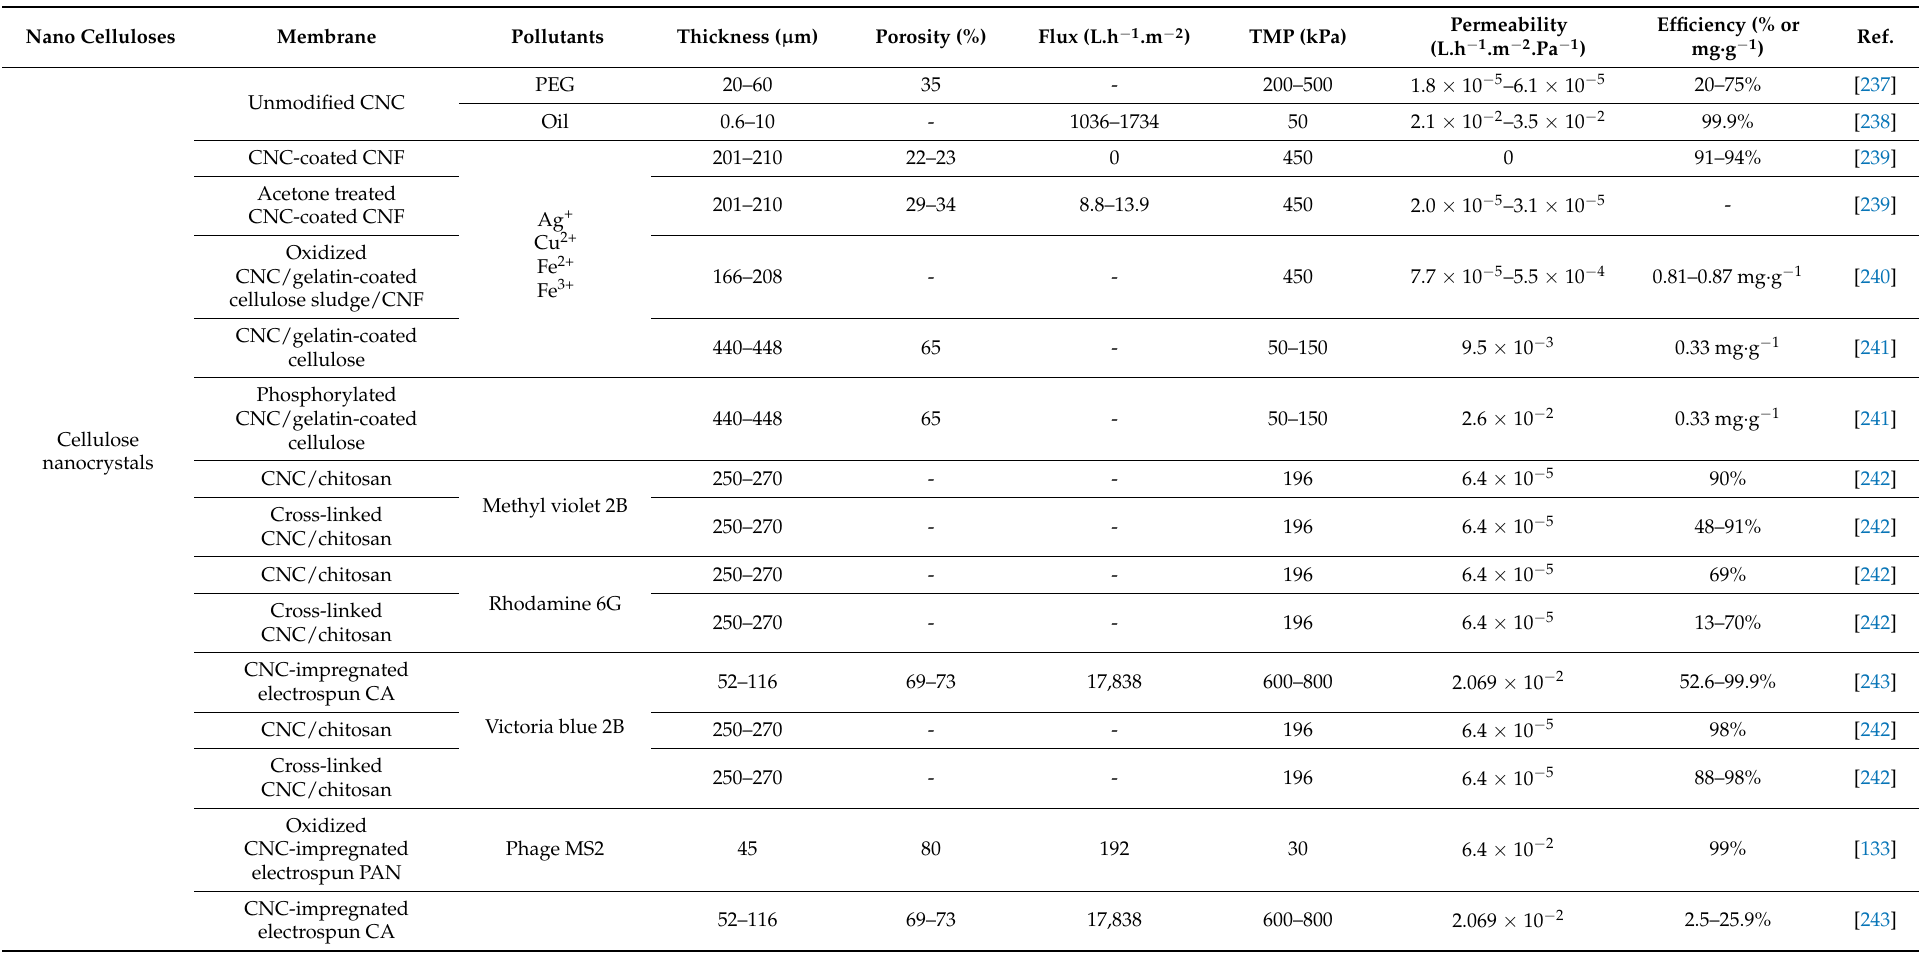
Table 7. Filtration membranes are made of nanocelluloses for wastewater treatment. CA, cellulose acetate; TMP, transmembrane pressure; PAE, polyamideamine-epichlorohydrin; PAN, polyacrylonitrile; PET, polyethylene